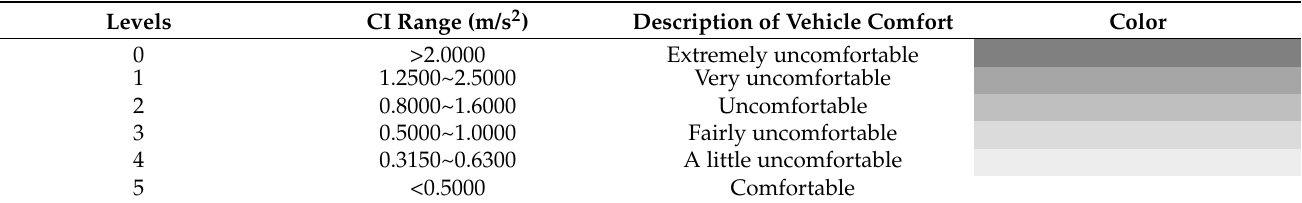
Table 4. Comfort evaluation level for autonomous vehicle braking.